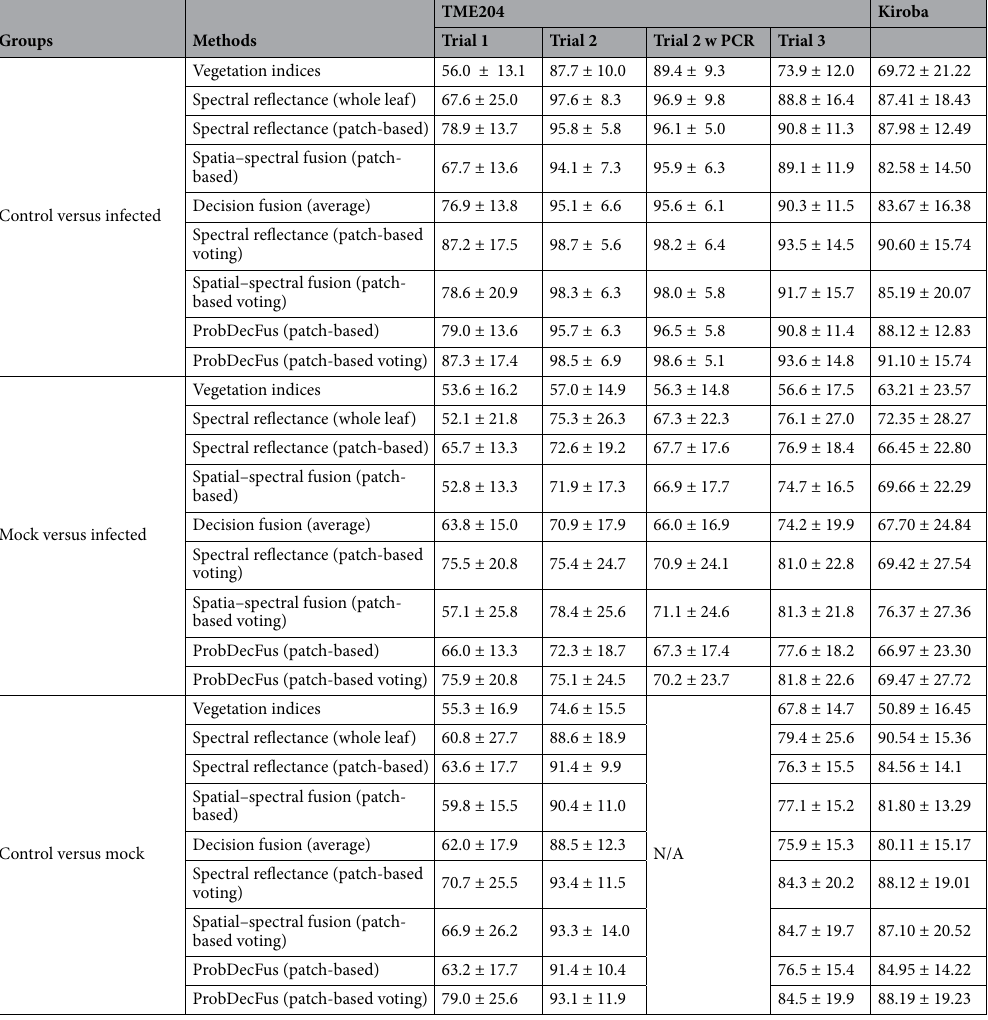
Table 2. Classification accuracy (%) at 28 dpi on leaf scans of three trials of Cassava-TME204-UCBSV and one trial of Cassava-Kiroba-UCBSV. ‘Trial 2 w PCR’ of Cassava-TME204-UCBSV denotes the classification results of the models re-trained only on those leaves that were later confirmed of infection with PCR at 88